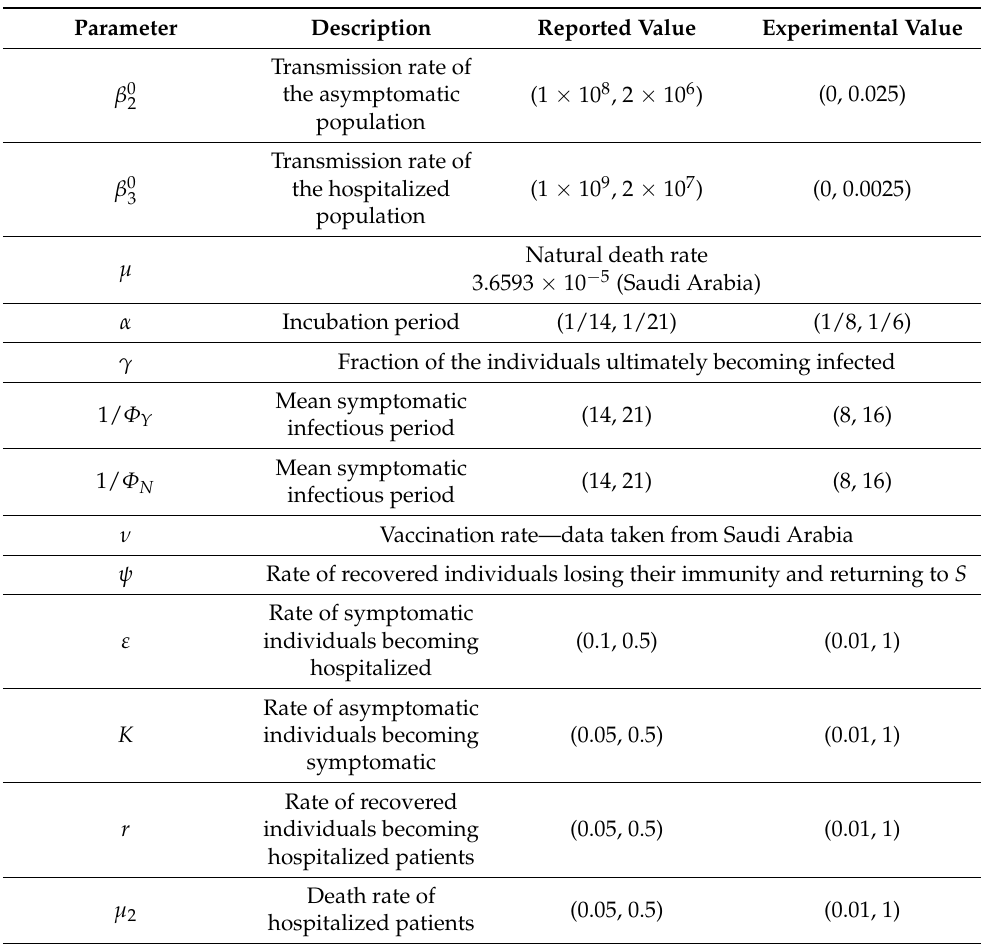
Table 1. Model parameters used in our model and their respective